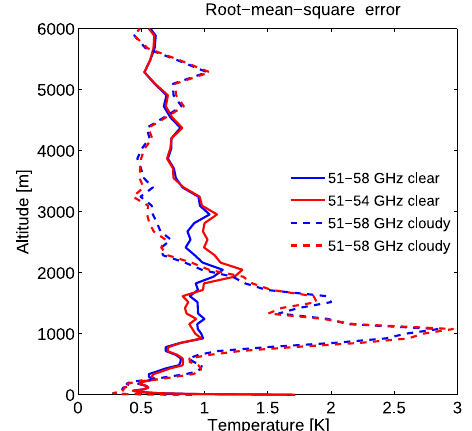
Figure 12. Vertical profiles of root-mean-square errors of 1DVAR retrievals using AROME 1h forecasts as backgrounds. Either all V-band channels (blue) or only opaque channels (red) are used. Re- sults are differentiated by clear-sky (solid lines) or cloudy-sky con- ditions (dashed lines)